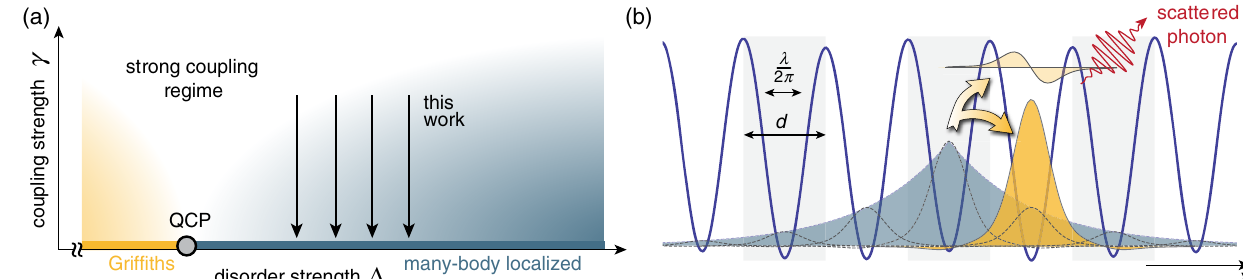
FIG. 1. Schematic phase diagram of an open MBL system and illustration of the effects of a single-photon scattering event. (a) Coupling a disordered system to a thermal environment destroys MBL on a time scale inversely proportional to the coupling strength γ . Nonetheless, for sufficiently weak couplings, the characteristics of both the MBL (i.e., persisting density pattern) and the ergodic Griffiths phase (i.e., power-law decay of density pattern [19 – 22]) survive sufficiently long to enable their experimental characterization. The shaded area represents the regime of weak dissipation in which the intrinsic dynamics of the phases can be discerned. Because of the diverging time scales at the critical point, the respective signatures become increasingly difficult to observe in its proximity. A sharp transition is only expected in the closed-system limit ( γ ¼ 0 ), while finite dissipative couplings are expected to produce a crossover regime between the two characteristic dynamics, similar to the effect of temperature in ground-state quantum phase transitions. Black arrows indicate the regime that is considered in this work. (b) Schematic of a scattering event. An atom in an initial localized superposition of Wannier states (blue) becomes localized on the length scale of the scattered photon ’ s wavelength λ = 2 π , which, in our system, is less than the lattice constant d . This dephases superpositions to incoherent mixtures of single Wannier states in the ground band (yellow) and also produces a small population in higher bands (faint yellow), which can be seen as the result of position measurements with sublattice site resolution. Band excitations can then lead to atom loss since, in most excited bands, atoms are not